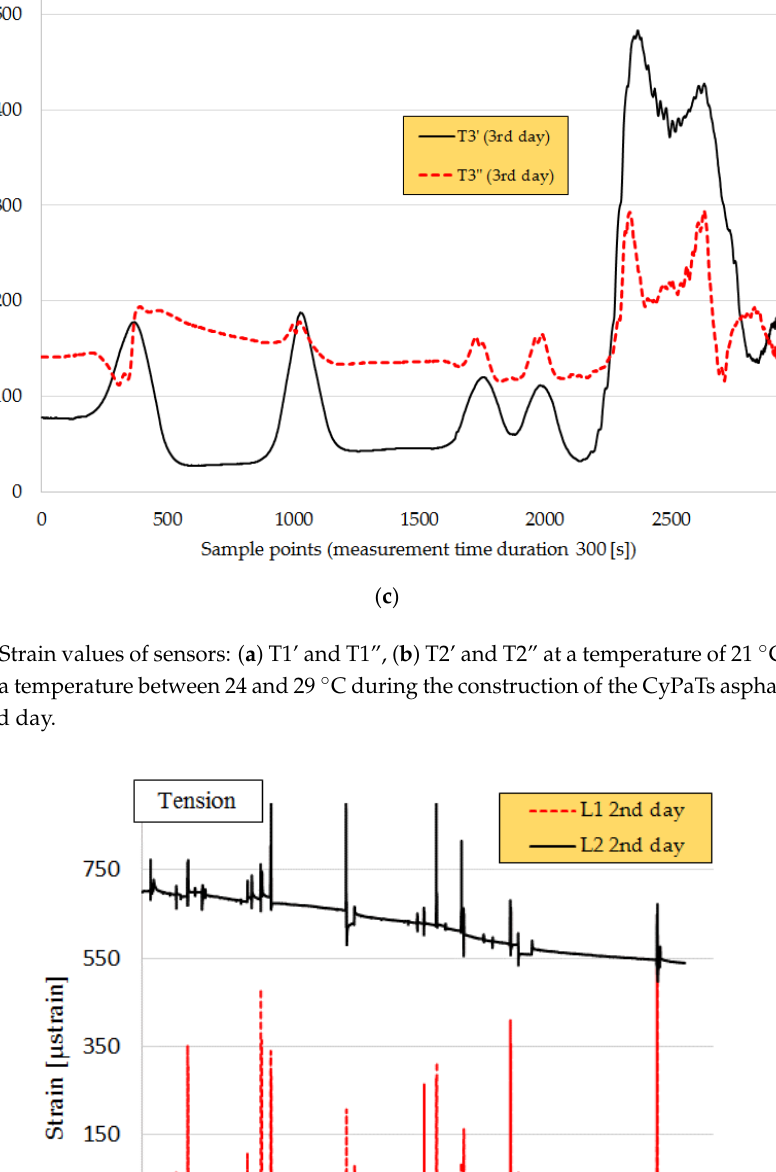
Figure 13. Strain values of sensors L1, L2, and L3 during the construction of CyPaTs asphalt pavement on the third day. Figures 12 and 13 show the responses of the sensors in the longitudinal direction of the cross- section of FBG chains in transverse and longitudinal directions. In this case, the sensors located closer to the cross-section configurations of FBGs were selected for the analysis. It can be observed that the sensors located at the lower asphalt layer (AC-14) experienced compression, and the sensors in the second base layer detected tension (see Figure 13). In addition, a difference in the response of the sensors in the longitudinal and transverse directions can be observed. The strain peaks are higher in the longitudinal (L) directions than in transverse directions (T). The response of the sensor in the location L1 for all 3 days shows that it was under compression (Figures 7, 12, and 13), but when taking a closer look at the response of the sensor at location T1’, in the transverse direction at the bottom of the first base layer (AC-14), it can be noticed that this sensor is under compression on the first day